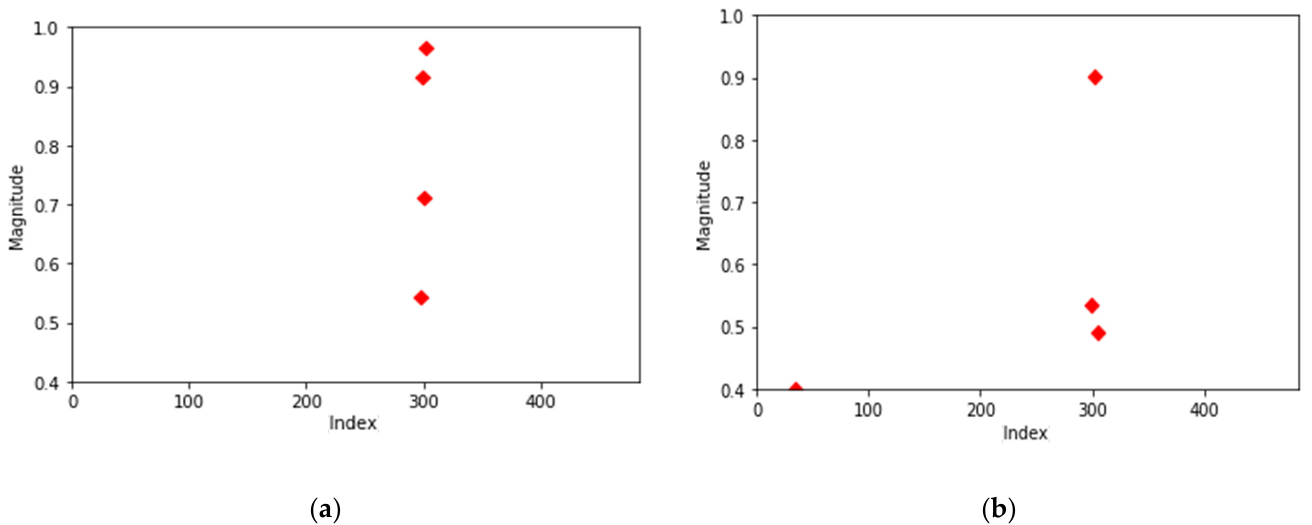
Figure 5. Center points of two most common normal data. ( a ) Most common normal data; ( b ) second most common normal data.